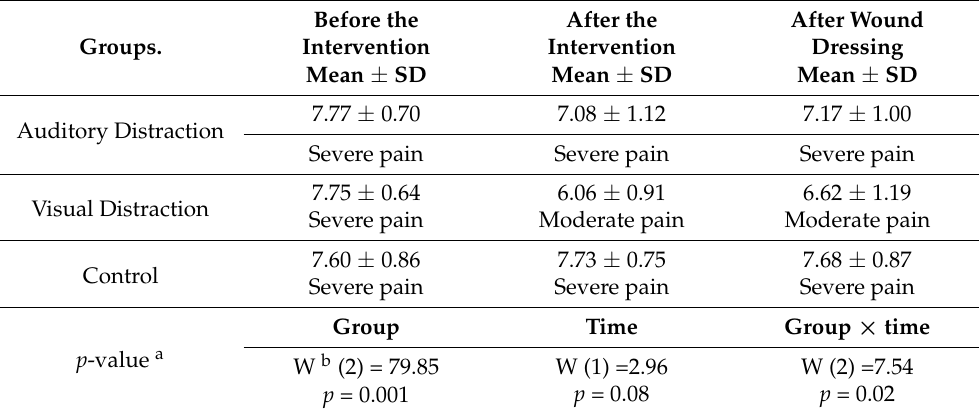
Table 2. Comparison of the mean scores of pain severity between the groups ( n = 135).